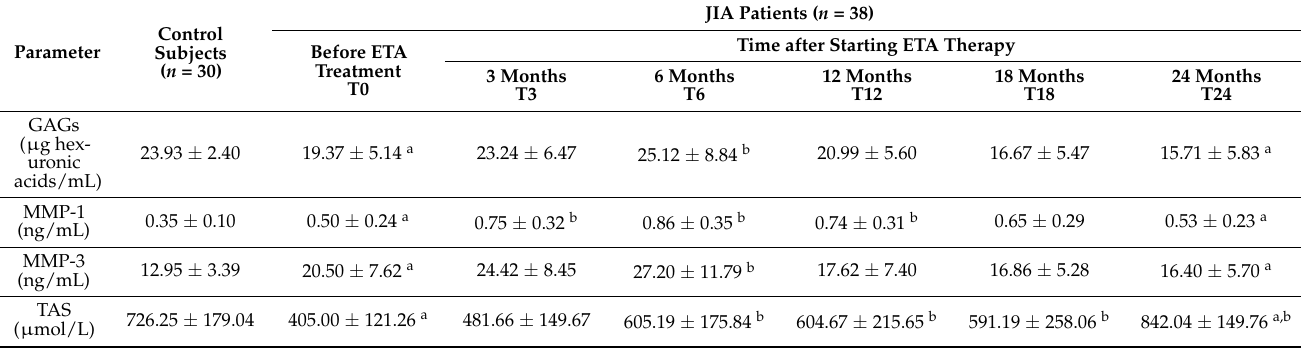
Table 2. The distribution patterns of plasma GAGs, MMP-1, MMP-3, and TAS in the healthy individ- uals (control subjects) and JIA